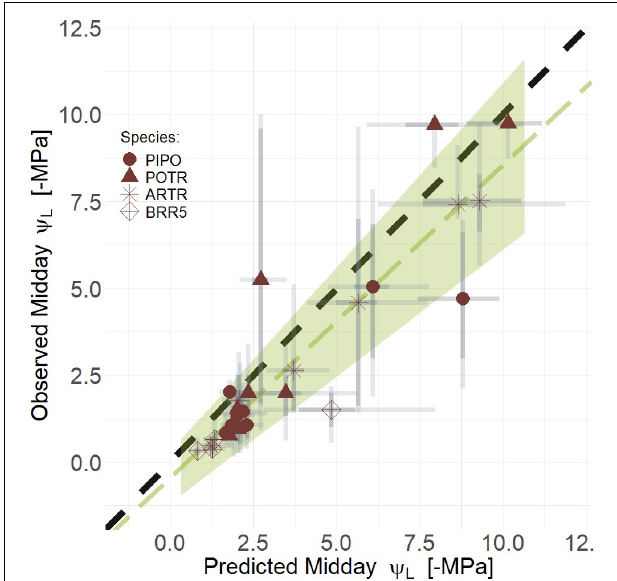
FIGURE 10 | Linear regression of predicted and observed (cid:57) L (Green line) and the corresponding 94% credible intervals of the linear regression (Green polygon). Coupling deltaT and RChlF improves predictive power as model midday leaf water potential ( (cid:57) L ) with respect to observed midday (cid:57) L during the progression of both moderate and severe drought. Maximum likelihood estimates (MLE, red) are presented for trends with 50% (dark gray) and 94% (light gray) creditable intervals for aspen (POTR, triangle), ponderosa pine (PIPO, circle), big sagebrush (ARTR, star), and oilseed Brassica rapa (BRR5, diamond). Error corresponds to model and measurement